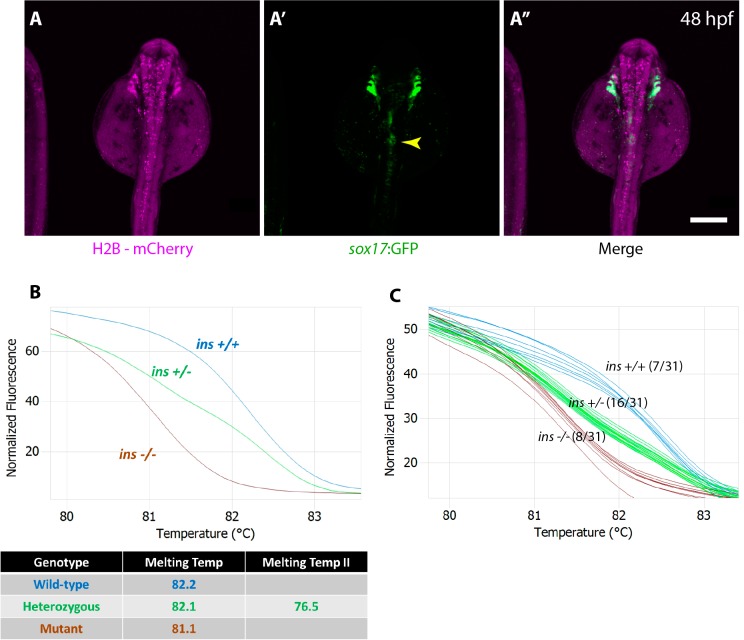
sox32 mRNA-injected cells contribute to host endoderm upon transplantation.(A–A”) Confocal images of a 48 hpf host embryo injected with H2B-mCherry mRNA (magenta) and transplanted with Tg(sox17:GFP) expressing donor endoderm showing the chimeric islet (yellow arrowhead). (B) High-resolution melt analysis patterns for genotyping ins +/+ (blue), ins +/- (green) and ins -/- (brown) animals. (C) Representative example of genotyping 31 chimeric adults, revealing 8 of 31 animals to be mutant (brown). Scale bar: 200 μm.